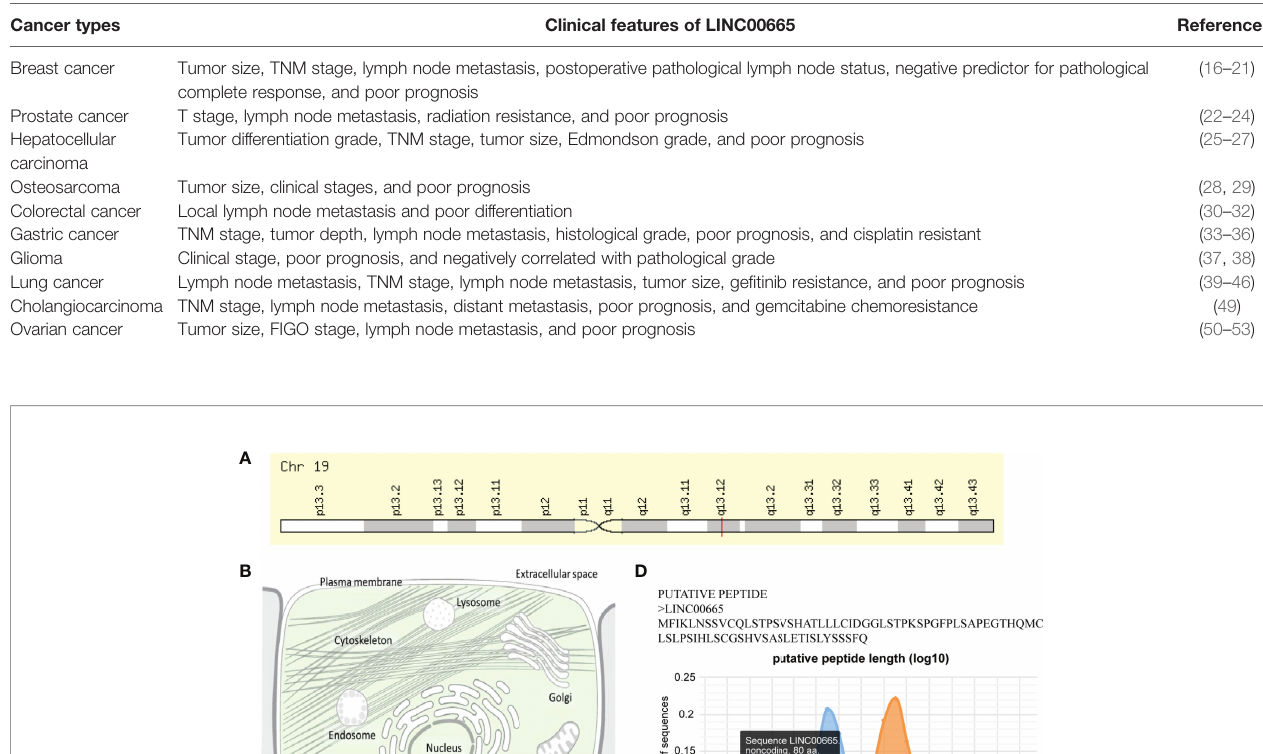
TABLE 2 | Clinical features of LINC00665 in human